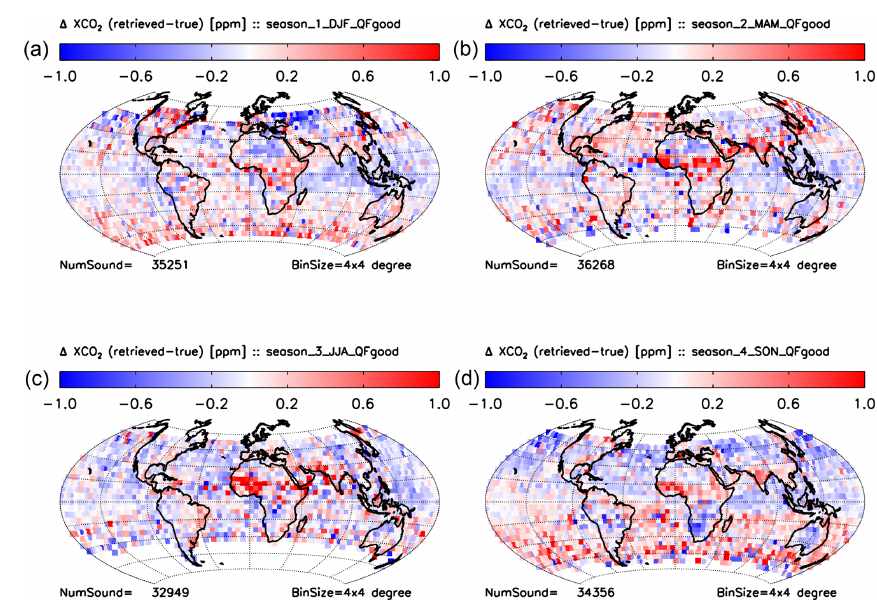
Figure 18. Seasonal maps of delta XCO 2 (retrieved – true [ppm]) in 4 ◦ latitude–longitude bins after quality filtering and bias correction.